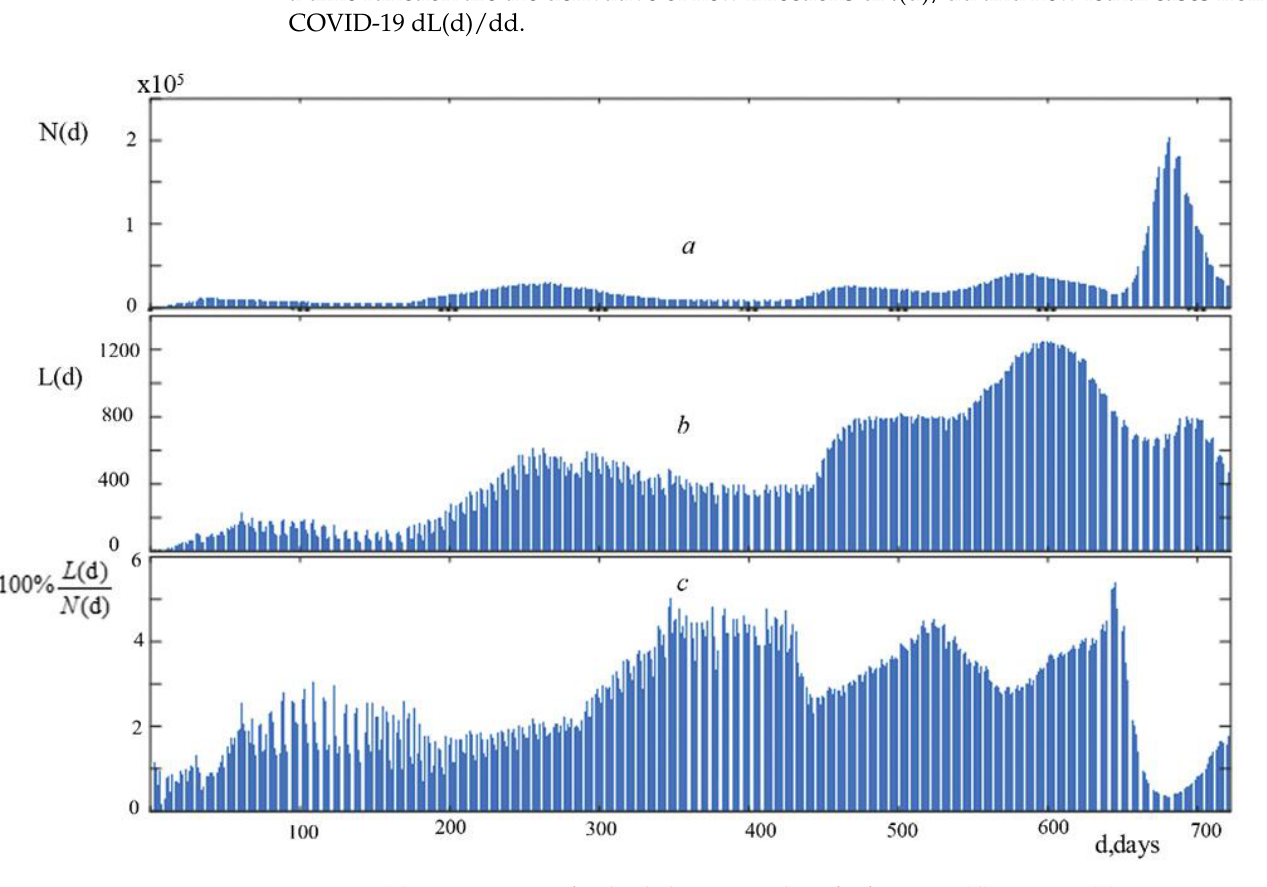
Figure 1. ( a ) — time variance for the daily new number of infections N(d)in Russia; ( b ) — time vari- Figure 1. ( a )—time variance for the daily new number of infections N(d)in Russia; ( b )—time variance ance for the daily new number of death L(d) in Russia; ( c ) — time variance for the relative death 100% for the daily new number of death L(d) in Russia; ( c )—time variance for the relative death 100% L(d)/N(d) in Russia. L(d)/N(d) in